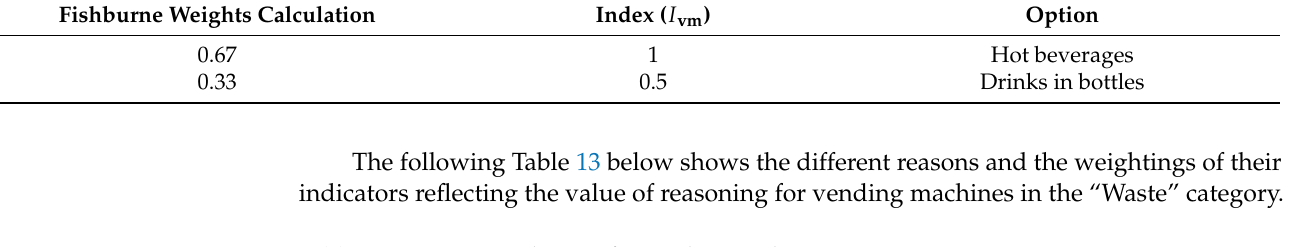
Table 13. Reasoning indicators for vending machine option.